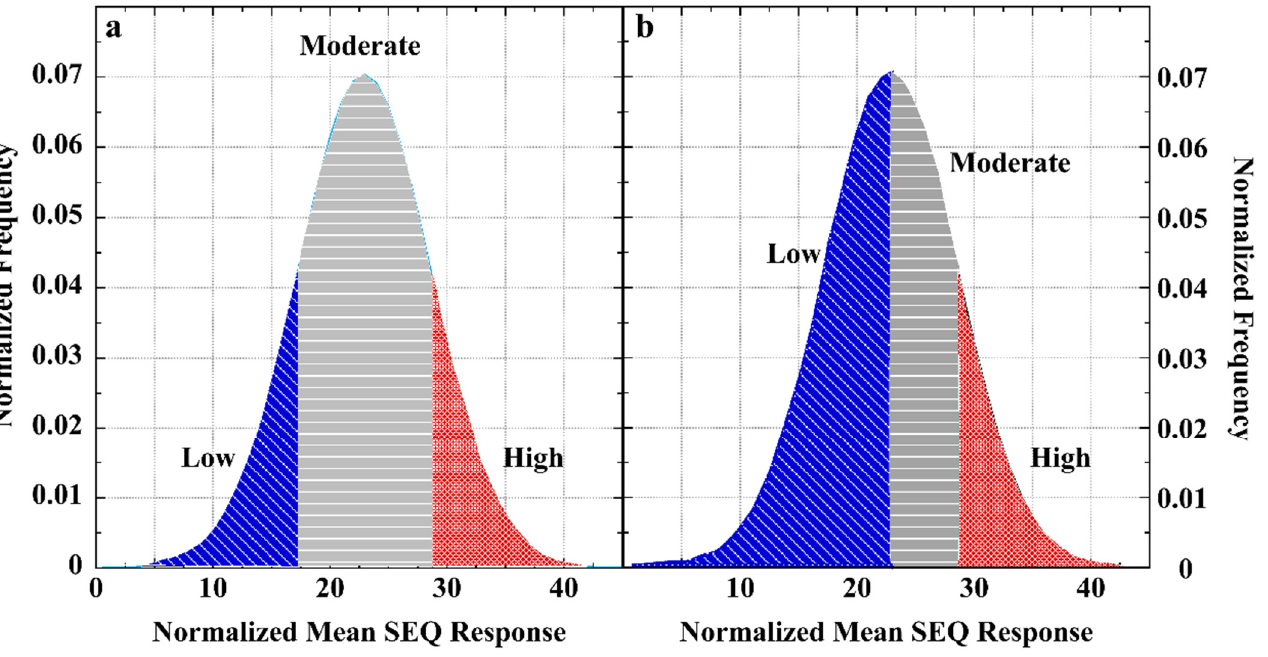
Figure 3. Panel ( a ) shows a Gaussian divided into Schneider et al., 1997, SEQ experience-rate groups for discriminant analysis [12]. In panel ( b ), the Gaussian is divided into Magley et al., 1999, or for discriminant analysis. In panel ( b ), the Gaussian is divided into Magley et al., 1999, or Munson et al., 2001, SEQ experience-rate groups for discriminant analysis [12,16,17]. Frequencies were nor- Munson et al., 2001, SEQ experience-rate groups for discriminant analysis [16,17]. Frequencies were malized by the reported total number of SEQ questions. normalized by the reported total number of SEQ